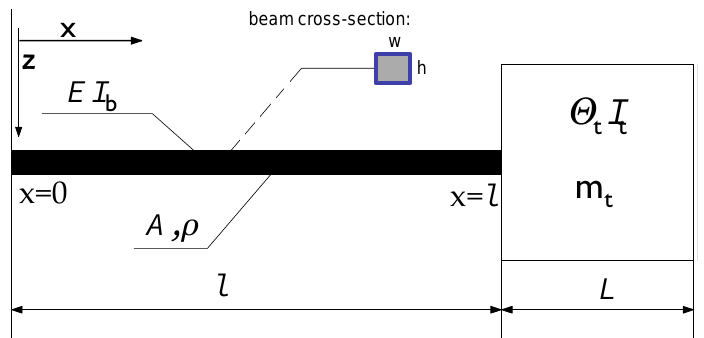
Figure 3. Parameters of the one-dimensional model. m t : mass of the tip mass. I t : area moment of inertia of the tip mass about the axis of bending. I b : area moment of inertia of the beam about the axis of bending. A : cross-section area. θ t : mass moment of inertia of the tip mass about the axis of bending. The nominal geometrical and material parameters are the same as in Section